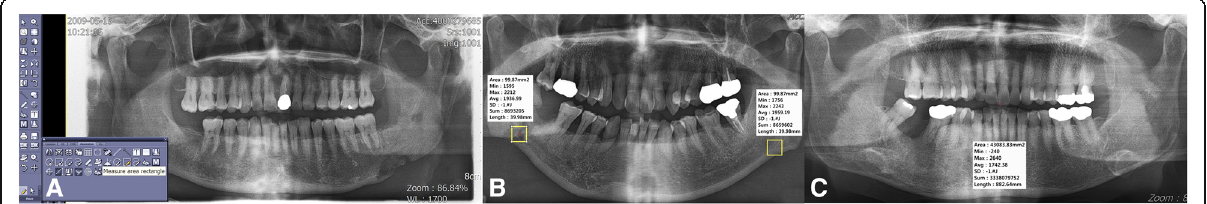
Fig. 1 Measurement method using “ measure area rectangle ” of INFINITT PACS® (INFINITT Healthcare, Seoul, South Korea) of bacterial osteomyelitis patient number 10 ( a ), comparison of photographic density in a patient with osteomyelitis for a focus in left mandible and control in right mandible of bacterial osteomyelitis patient number 12 ( b ), and maximum and minimum photographic density in panoramic radiograph of